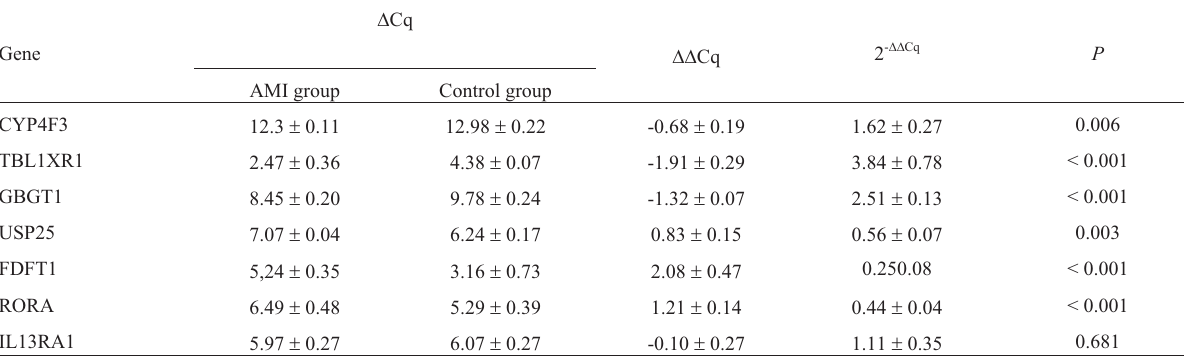
Table 5 - RT-PCR results of the candidate genes.